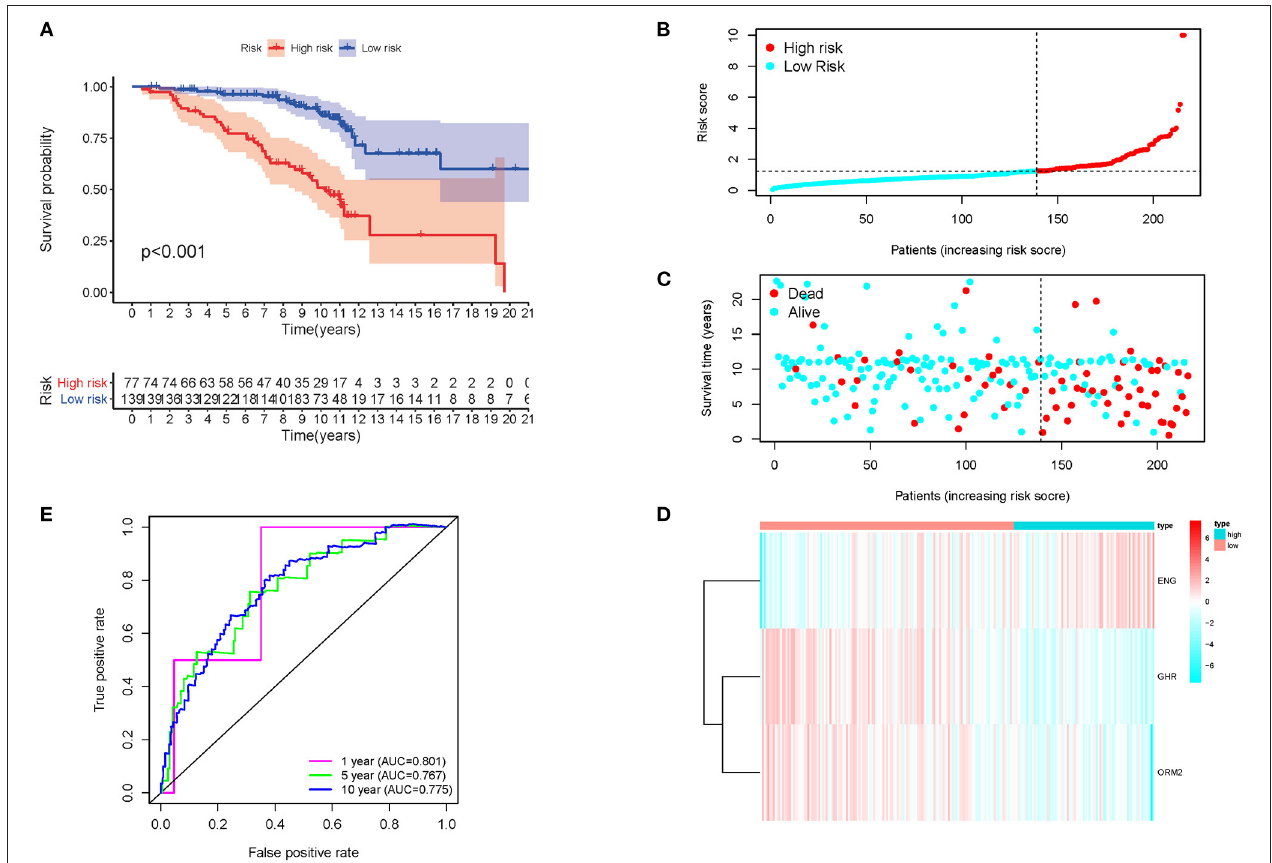
FIGURE 2 | K-M survival analysis, risk score distribution, and time-dependent ROC curves of a prognostic model in the HCV-related early-stage cirrhosis cohort. (A) K-M survival curve analysis between high and low-risk groups. The distribution of (B) immune risk score, (C) survival status, and (D) expression matrix of the three genes. (E) The time-dependent ROC curve analysis for measuring the predictive performance on